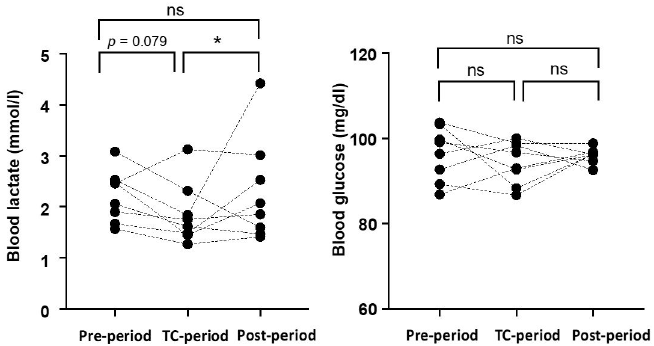
Figure 2. Changes in morning blood lactate and blood glucose levels in each period. The dots represent the average values for the subjects during one week. * p < 0.05 vs. the